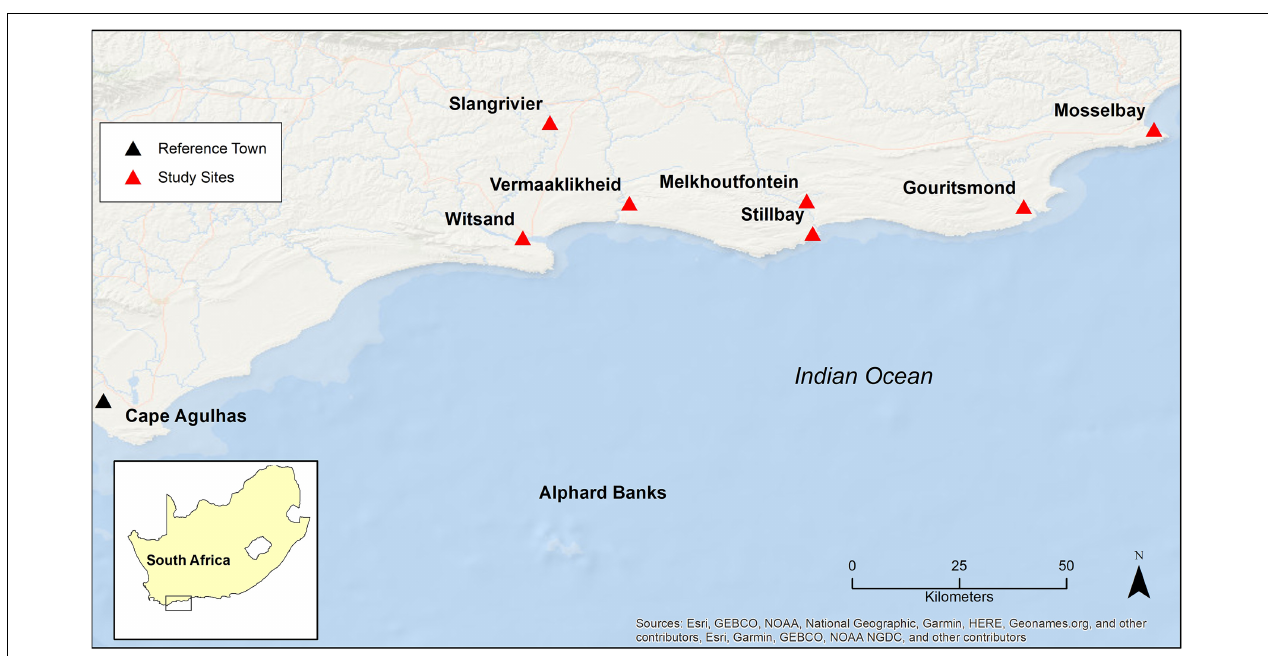
FIGURE 1 | Map of the research area. Mossel Bay - large urban centre situated on the coast; Bitouville - situated next to Gouritsmond at the Gourits River mouth; Melkhoutfontein - situated approximately 8 km from Still Bay on the coast, Vermaaklikheid - 7 km from the coast as the crow flies, but fishers often travel 47 km by road to launch in Still Bay; Slangrivier - situated 26 km inland as the crow flies, fishers travel 38 km by road to Witsand where boats are launched into the Breede River mouth.